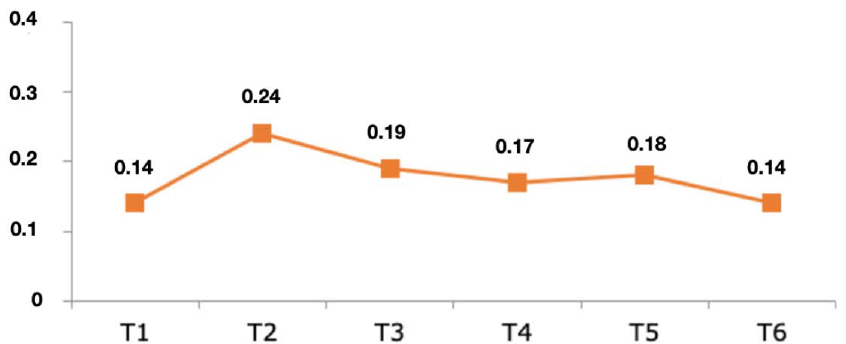
Figure 9. Graphic showing the mean values of GI, from the first year of follow-up (T1) until the sixth